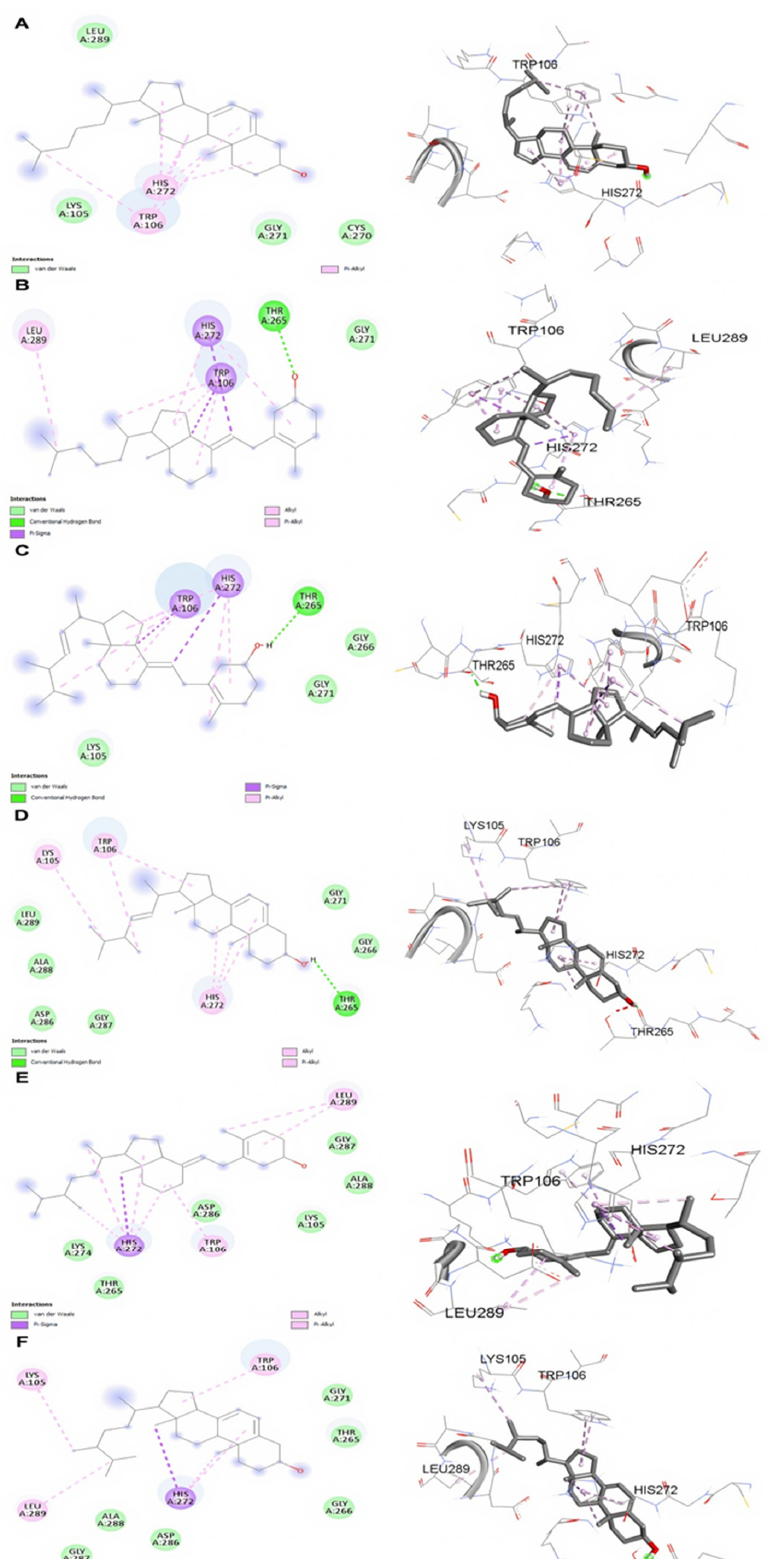
Molecular docking 2D and 3D interaction representation between SARS-2 PL- pro and ( A ) 7-dehydrocholesterol, ( B ) cholecalciferol, ( C ) ergocalciferol, ( D ) ergosterol, ( E ) 22,23-dihydroergocalciferol, and ( F )